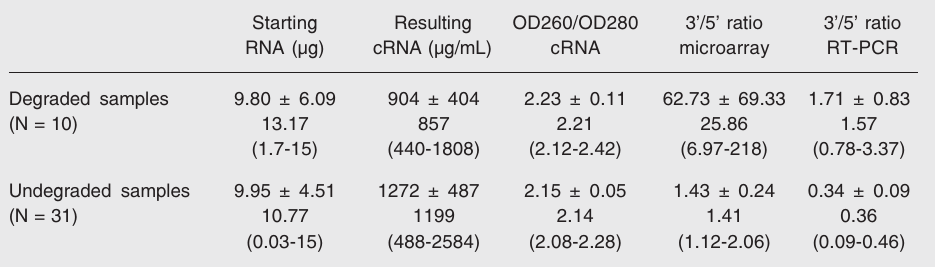
Table 1. Summary of the parameters tested to characterize biotinylated cRNA quality.